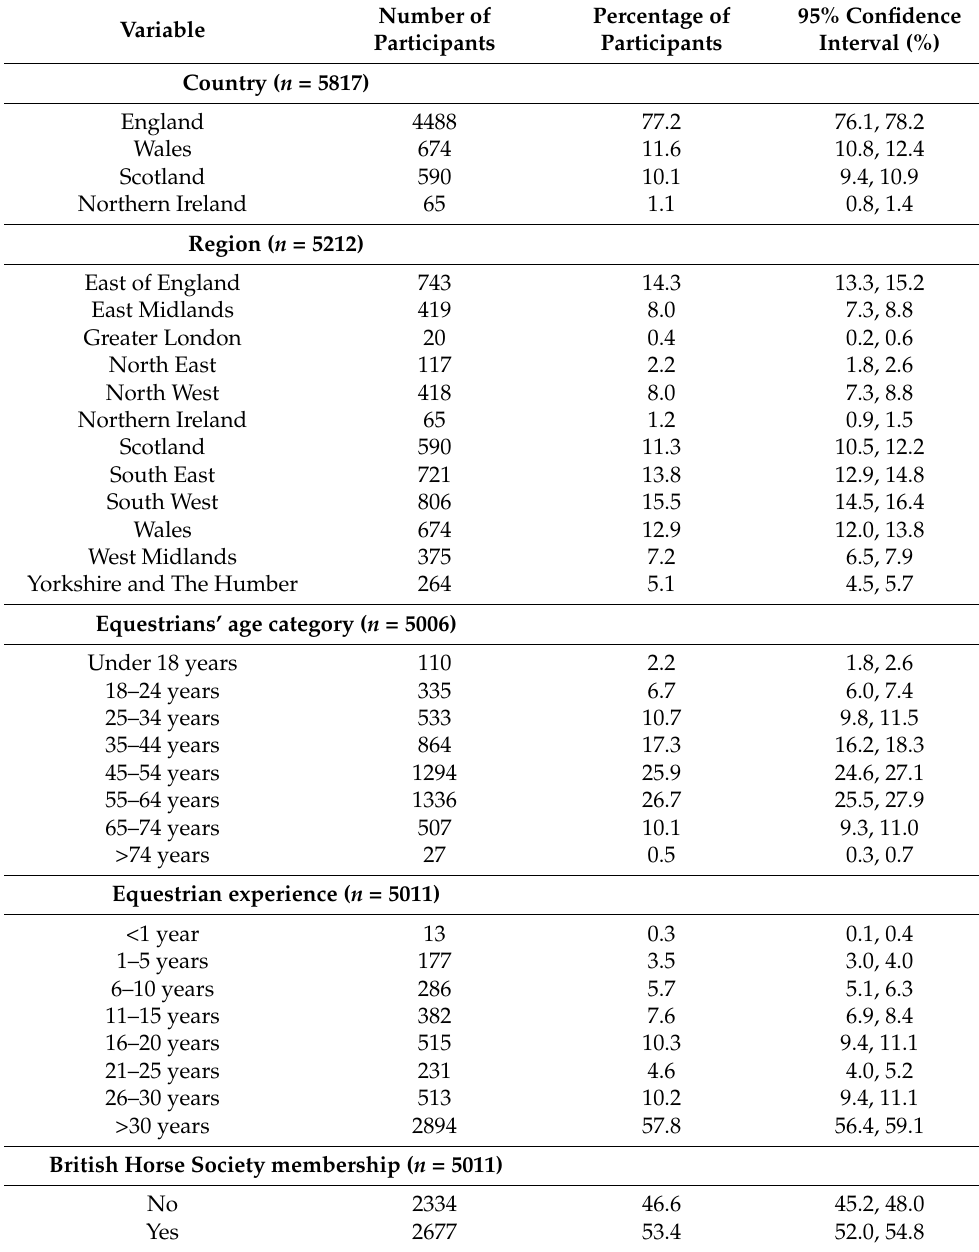
Table 1. A summary of the demographics of UK equestrians ( n = 5817) that completed a questionnaire regarding their activity when caring for and exercising their horses, ponies, donkeys or